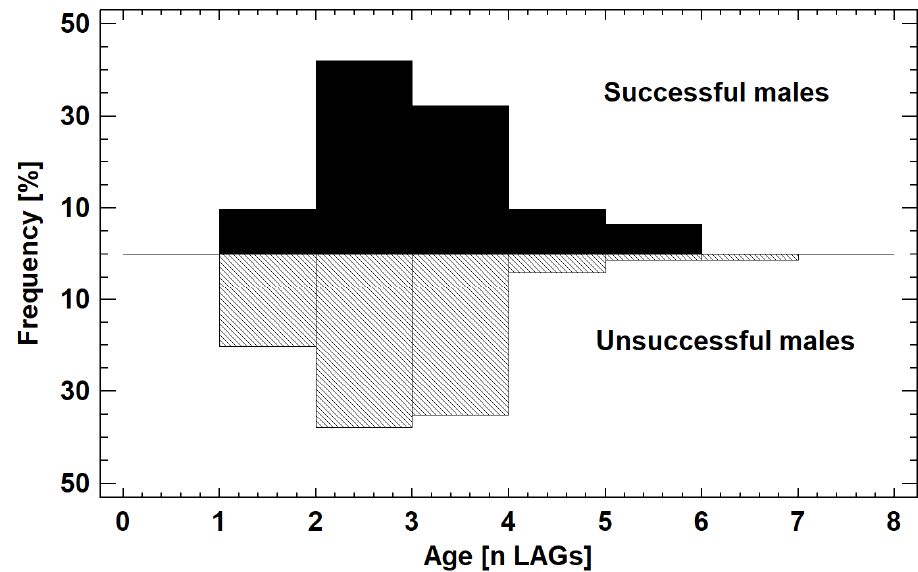
Figure 3. Age structure of male breeding R. arenarum . For statistical details see